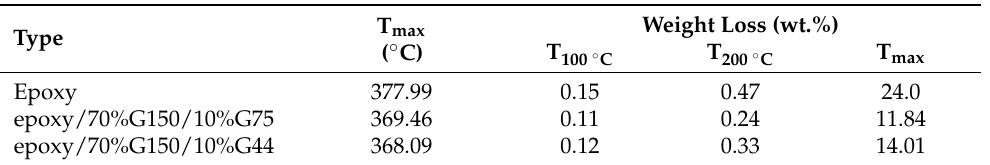
Table 2. Maximum decomposition temperatures and weight loss of the epoxy and epoxy/G compos- ites at different temperatures.